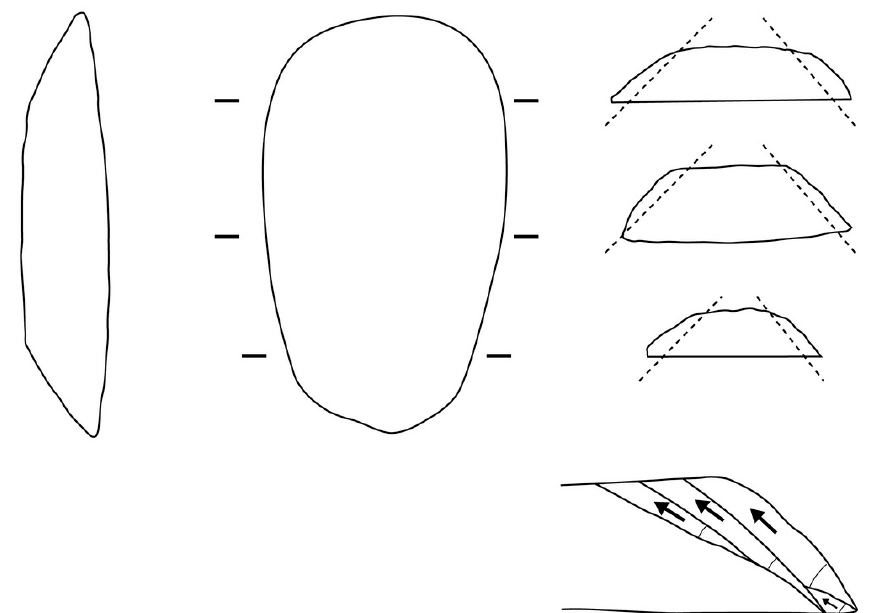
Figure 10. Schéma synthétique d’aménagement d’un galet de section plano-convexe en partant de la surface plane vers la surface convexe. Figure 10. Schematic drawing of a plano-convex pebble from the flat surface to the convex